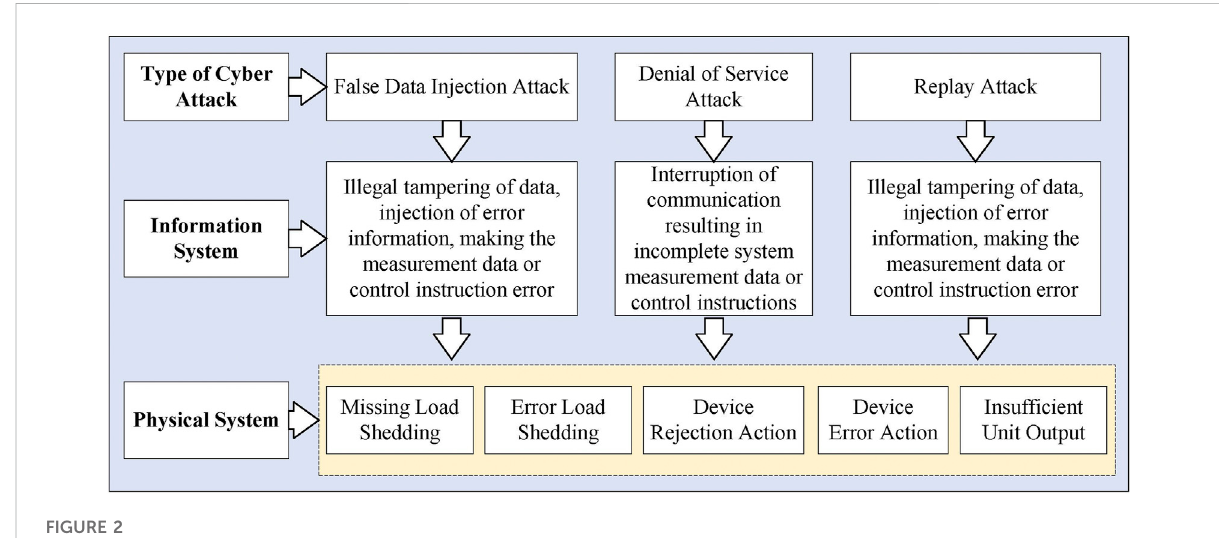
FIGURE 2 The in fl uence of various cyber attacks on